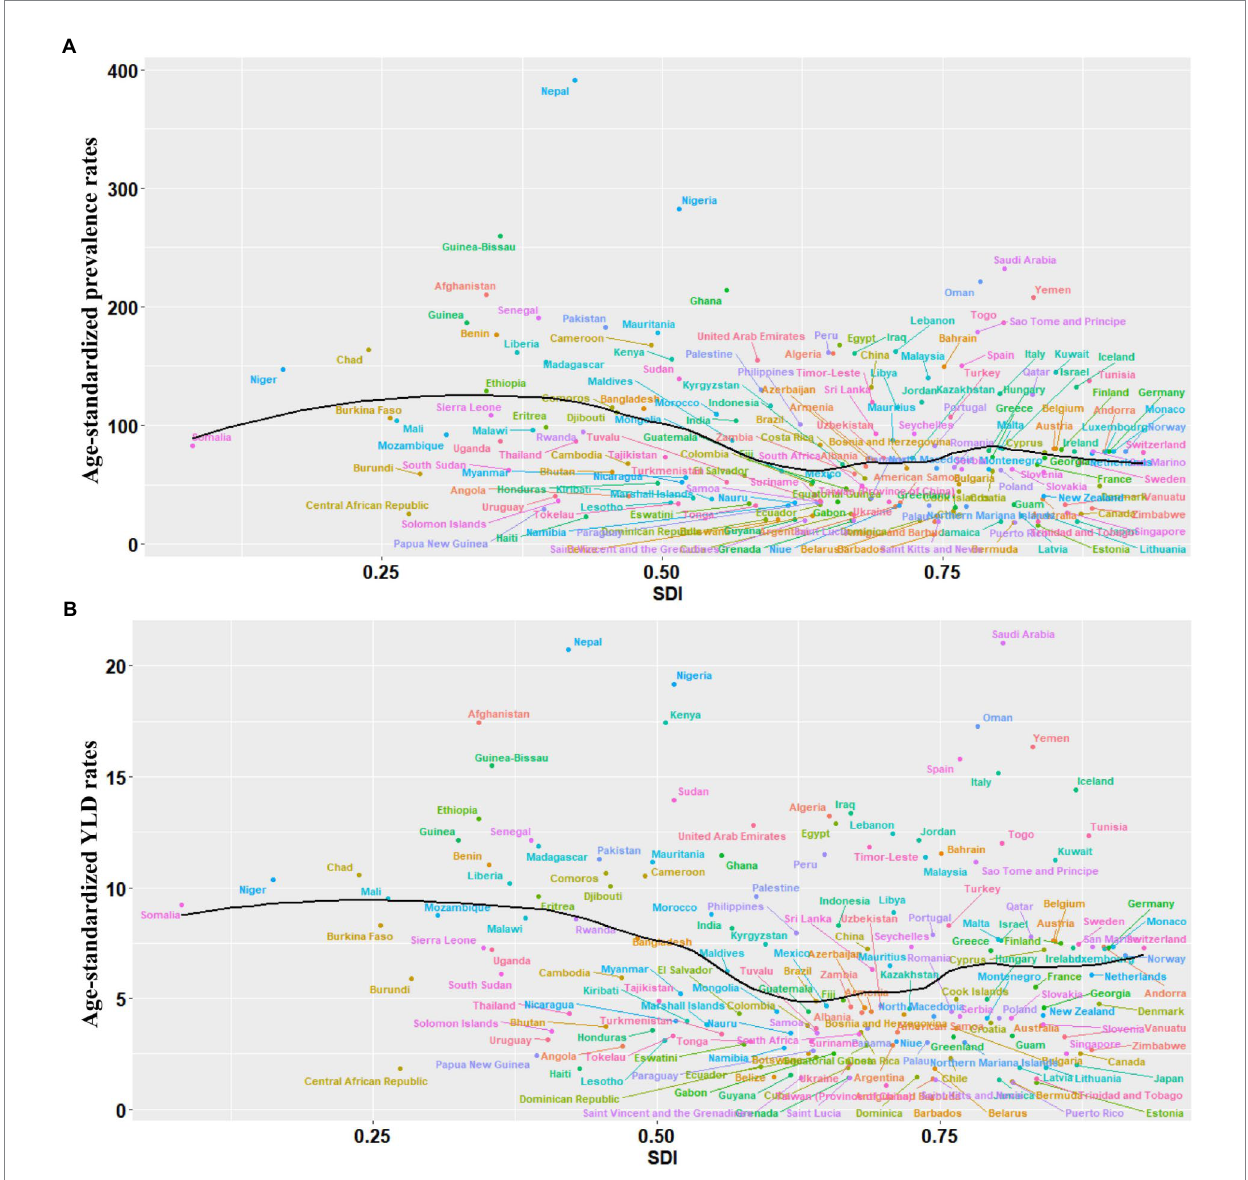
FIGURE 3 Global burden of the prevalence and YLDs of AMD by SDI. (A) The black line represents the average expected relationship between SDIs and age- standardized prevalence rates for AMD based on values from 204 countries and territories in 2019. (B) The black line represents the average expected relationship between SDIs and age-standardized YLD rates for AMD based on values from 204 countries and territories in 2019. AMD, age-related macular degeneration; SDI, socio-demographic index; YLDs, years lived with